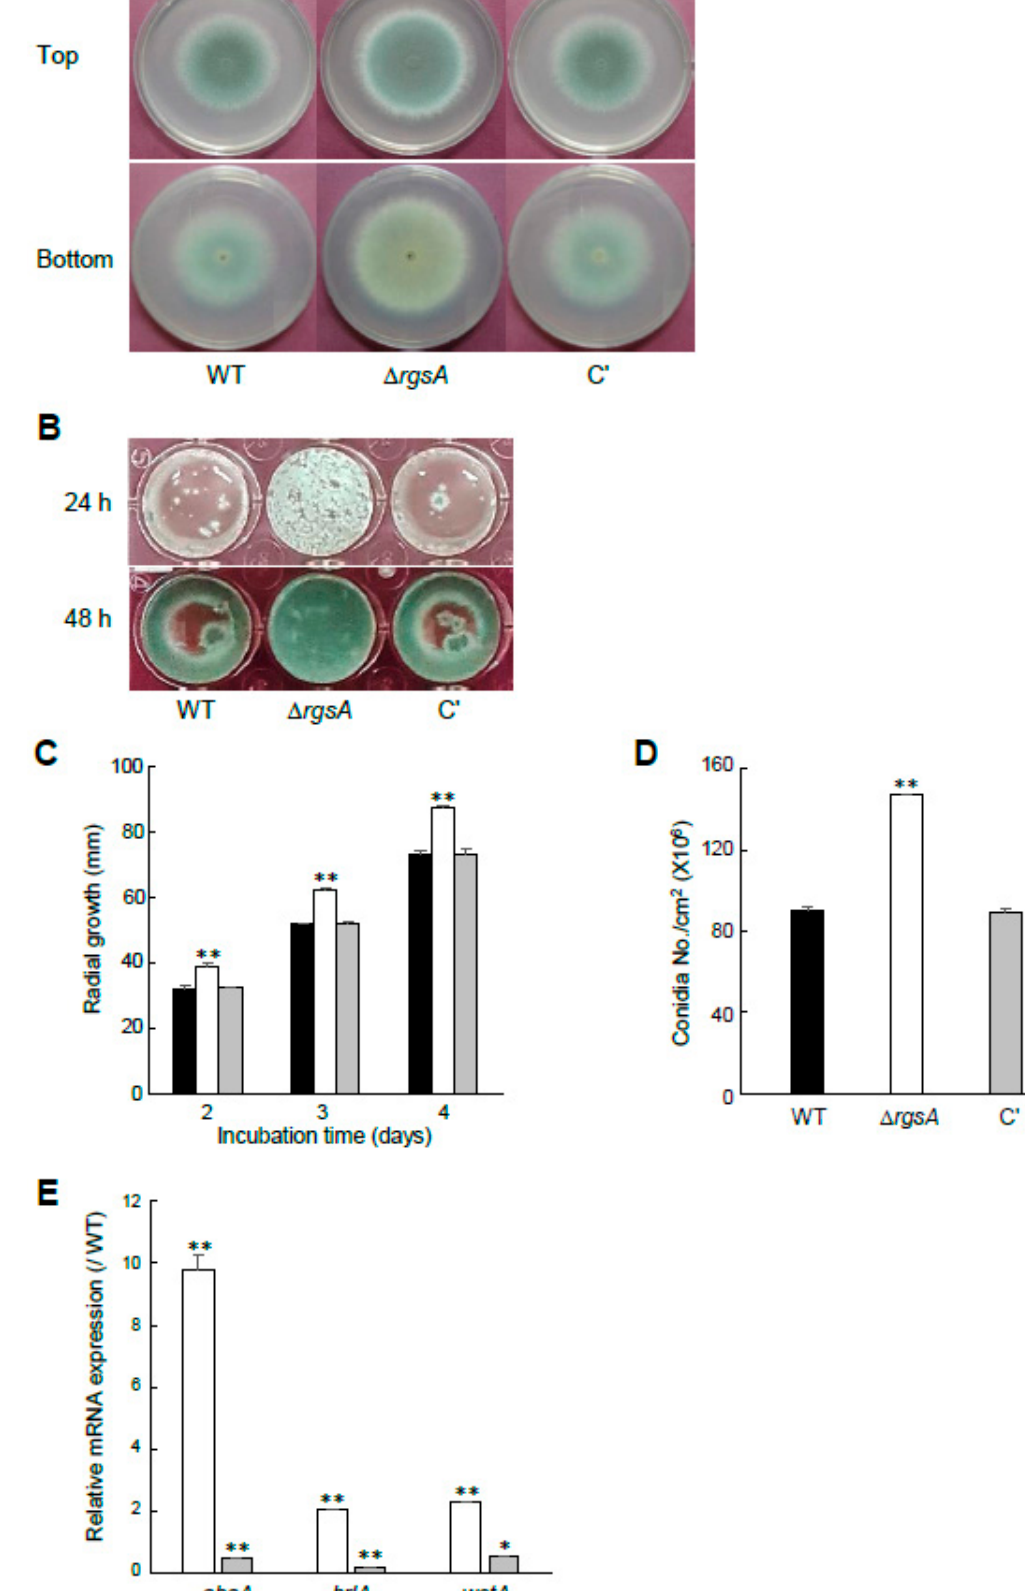
Figure 1. The role of RgsA in fungal growth and development. ( A ) Colony photographs of WT (AF293), Δ rgsA , and complemented (C ′ ) strains point-inoculated on solid MMY and grown for 3 days.